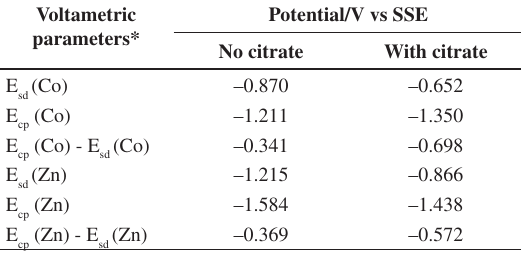
Table 3. Voltametric parameters obtained from linear voltametric experiments of Co 2+ or Zn 2+ solutions, containing or not sodium citrate 0.10 mol L –1 , on graphite